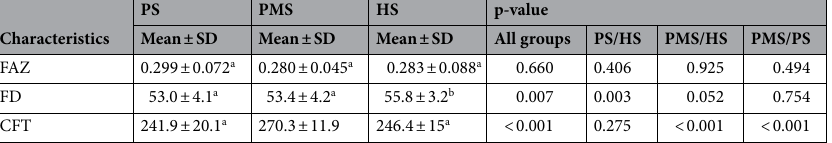
Table 2. Comparison of FAZ, FD and CFT between groups. PS psoraisis group, PMS psoraisis and metabolic syndrome, HS healthy control, FAZ foveal avascular zone, FD foveal density, CFT central foveal thickness. There was a statistically significant difference between a variable with a different letter, no significant difference between a variable with the same letter.